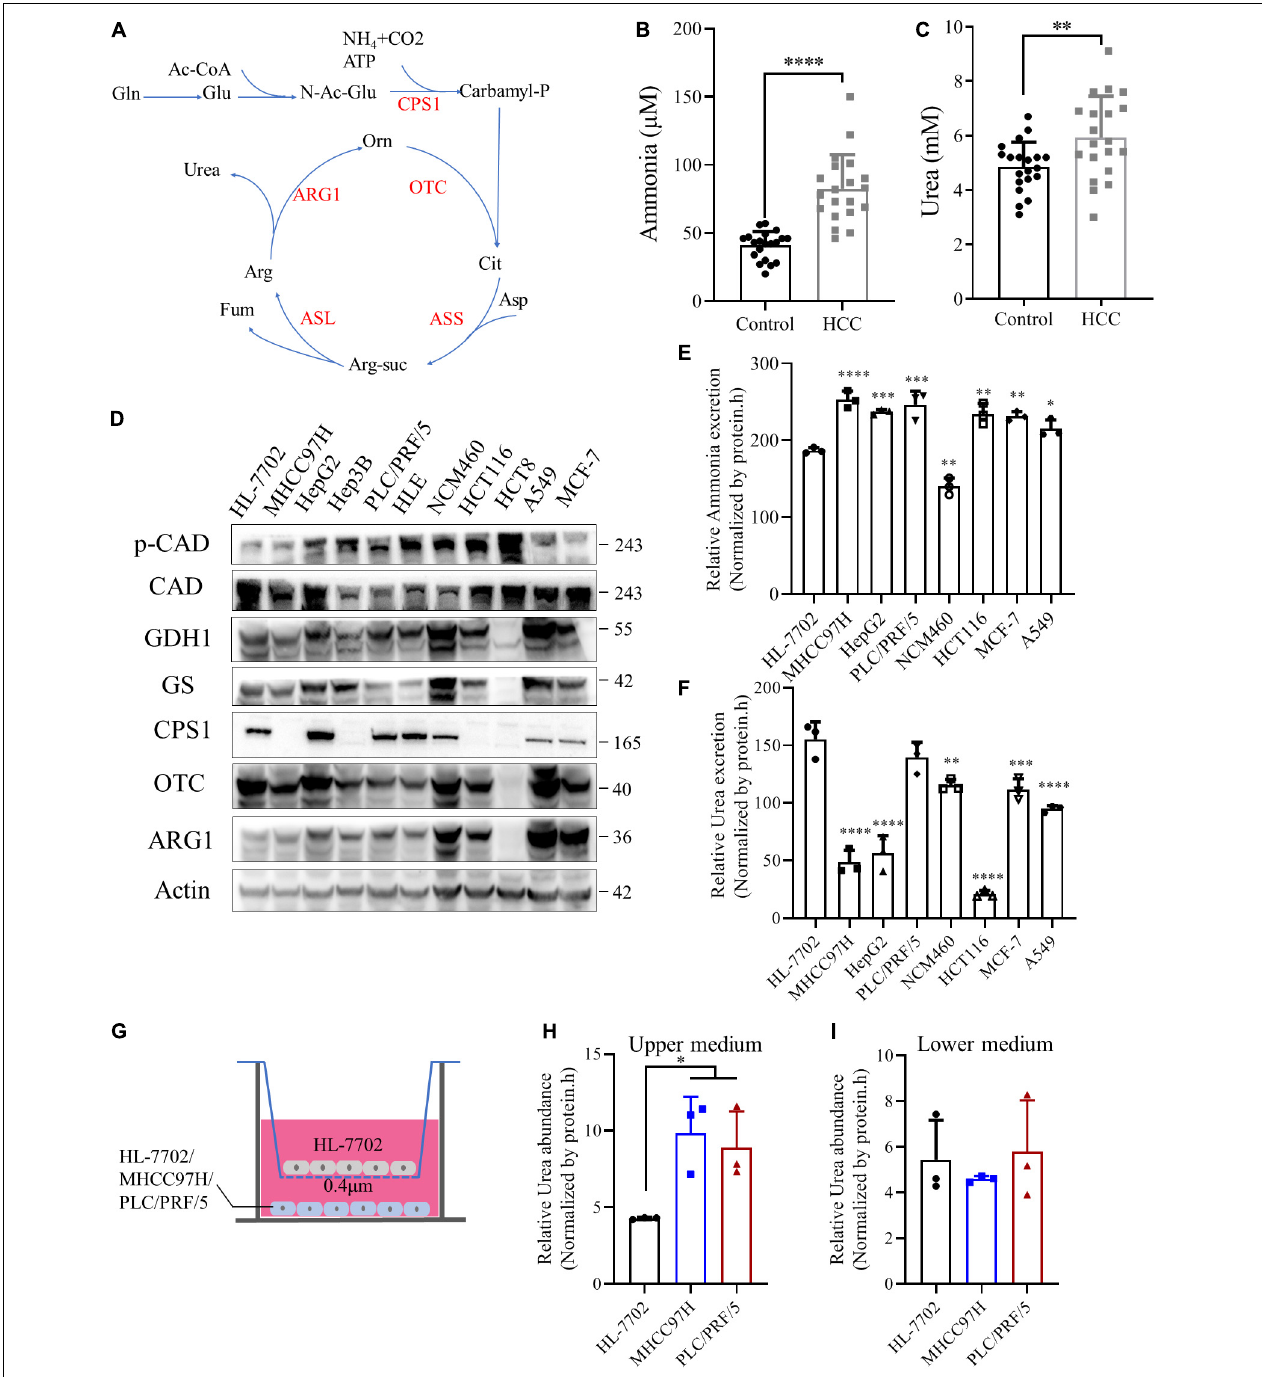
FIGURE 5 | Ammonia is metabolized by normal liver and cancer cells into urea . (A) A schematic to show the metabolism of urea cycle. (B) Scatter plots with bar of plasma ammonia of 20 age and sex matched control and HCC patients. (C) Scatter plots with bar of serum urea of 20 age and sex matched control and HCC patients. (D) Western blot of lysates from HL-7702, MHCC97H, HepG2, Hep3B, PLC/PRF/5, HLE, NCM460, HCT116, HCT8, MCF-7 and A549 cells. (E) Excretion of ammonia to medium from HL-7702, MHCC97H, HepG2, PLC/PRF/5, NCM460, HCT116, MCF-7 and A549 cells. (F) Excretion of urea to medium from HL-7702, MHCC97H, HepG2, PLC/PRF/5, NCM460, HCT116, MCF-7 and A549 cells. (G) Schematic diagram of co-culture cell model. HL-7702, MHCC97H or PLC/PRF/5 were cultured in the lower layer respectively, and the upper layer was HL-7702. (H) Relative urea abundance in the upper medium of the cell lines as indicated. (I) Relative urea abundance in the lower medium of the cell lines as indicated. Values are the means ± SD of three independent experiments. ∗ p < 0.05; ∗∗ p < 0.01, ∗∗∗ p < 0.001, ∗∗∗∗ p < 0.0001.